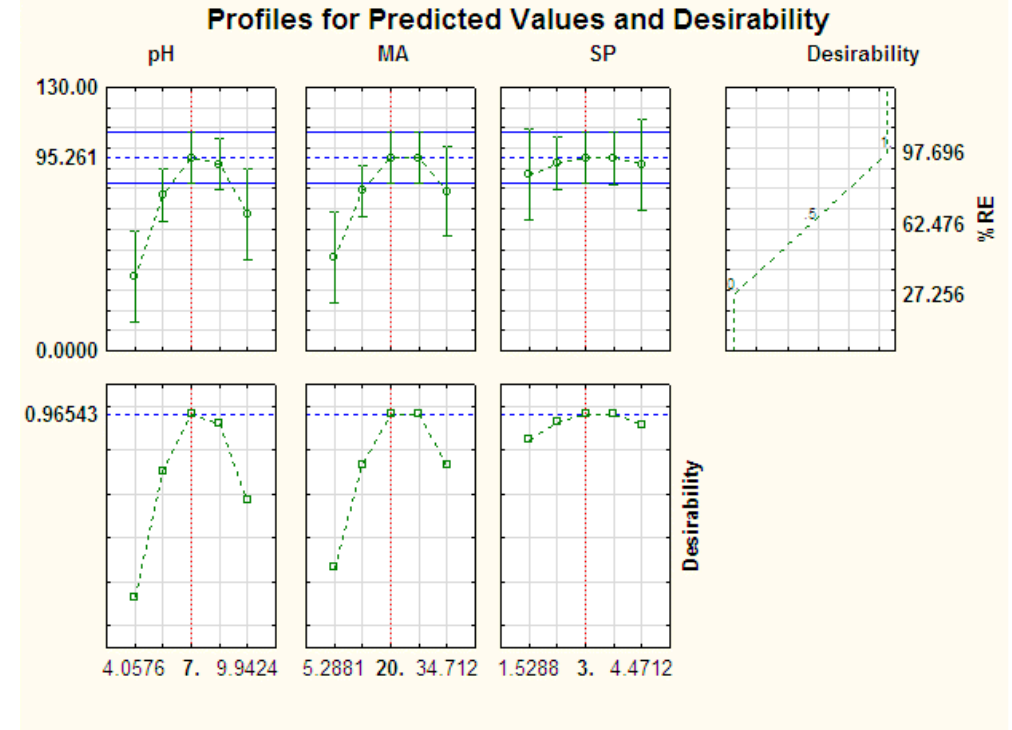
Figure A4. Profiles for predicated values and desirability function for removal of